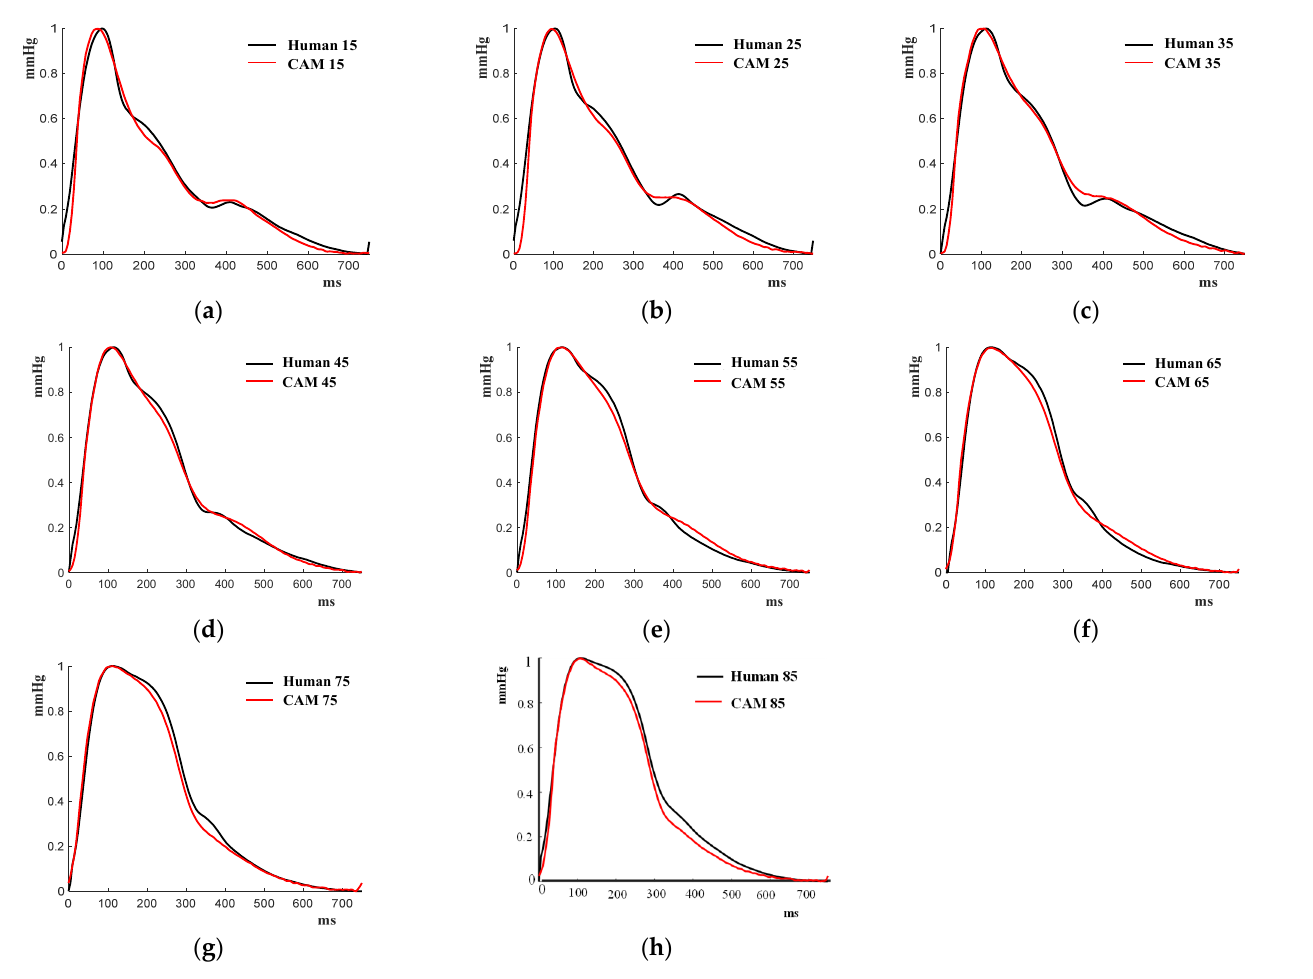
Figure 6. Comparison of human pulse pressure waveforms and artificial waveforms generated by 3D cam simulator: ( a ) 15-year-old waveforms in human and the simulator; ( b ) 25-year-old waveforms; ( c ) 35-year-old waveforms; ( d ) 45-year-old waveforms; ( e ) 55-year-old waveforms; ( f ) 65-year-old waveforms; ( g ) 75-year-old waveforms; ( h ) 85-year-old waveforms.